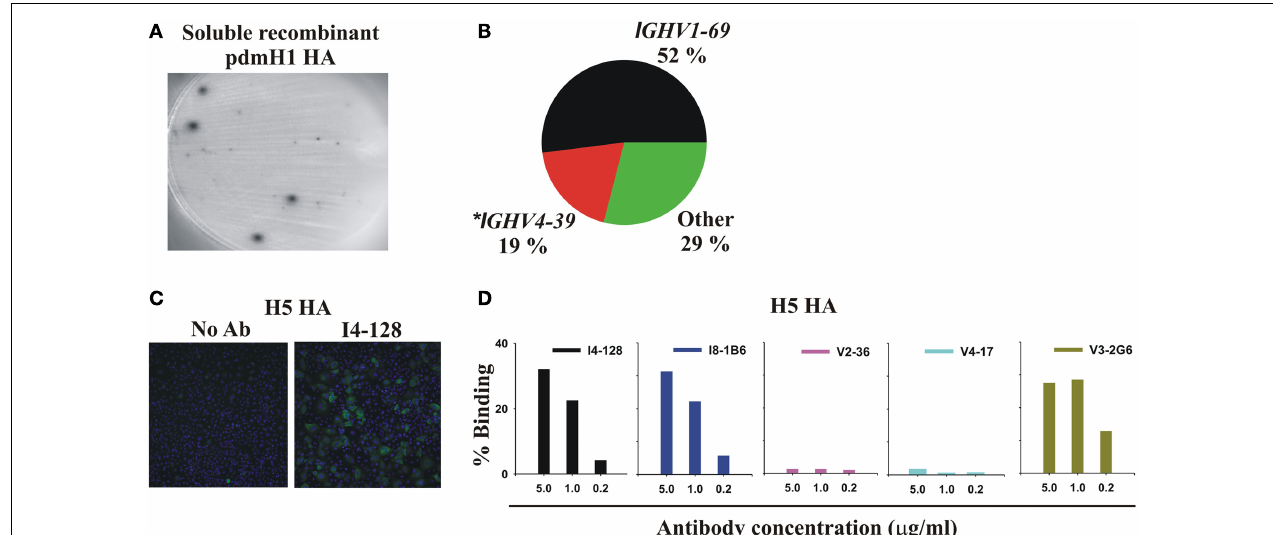
expressed by the A549 human cell-line. Binding was quantified by indirect immunofluorescence and the Cellomics instrument. (C) Cellomics images of cells stained with either secondary antibodies alone or first with mAb I4-128 (5 μ g/ml). (D) Percentage of cells stained with varying concentrations of the indicated mAbs. Note that anti-stem HA mAbs that did not use IGHV1-69, like V3-1E8 and I5-52 also bound to the H5 HA in this assay (data not shown). KE5, an human anti-HCMV monoclonal antibody (McLean et al., 2005), was used as a negative control with no significant binding observed (data not